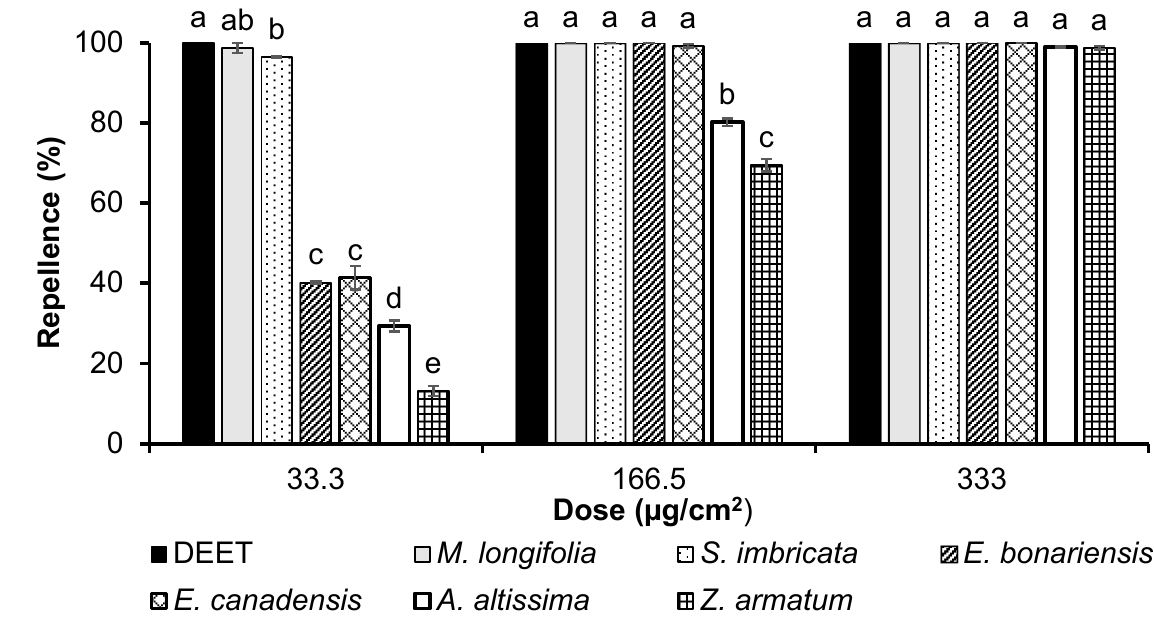
Figure 1. Repellency exhibited by DEET and essential oils, tested at the doses of 33.3 µ g/cm 2 , 166.5 µ g/cm 2 , and 330 µ g/cm 2 against Ae. aegypti female . Bars, indicated by different letters, denote significant differences ( p < 0.05) among different treatments when tested at the same concentration by ANOVA post hoc Tukey test. Error bars denote the standard error (n = 5).